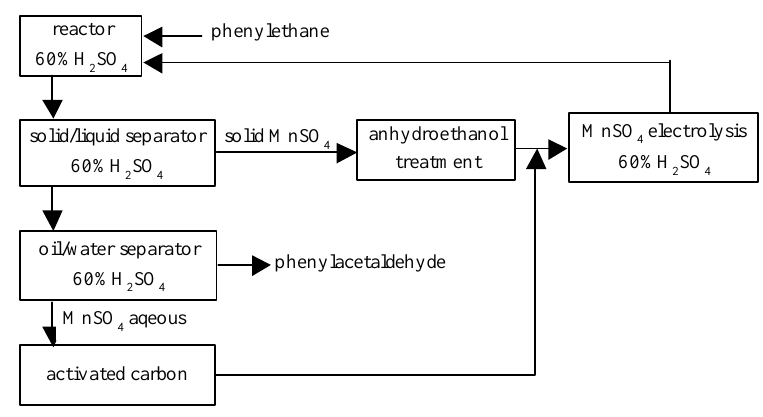
FIGURE 4 . Flow diagram of the process of heterogeneous indirect electroproduction of phenylacetaldehyde in 60% H 2 SO 4 with recycling of the